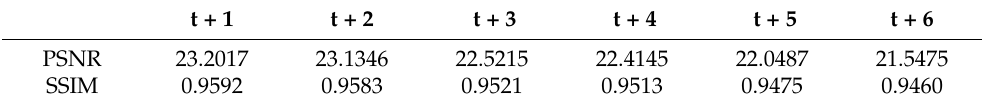
Table 2. Average evaluation results at each time step from t + 1 to t +